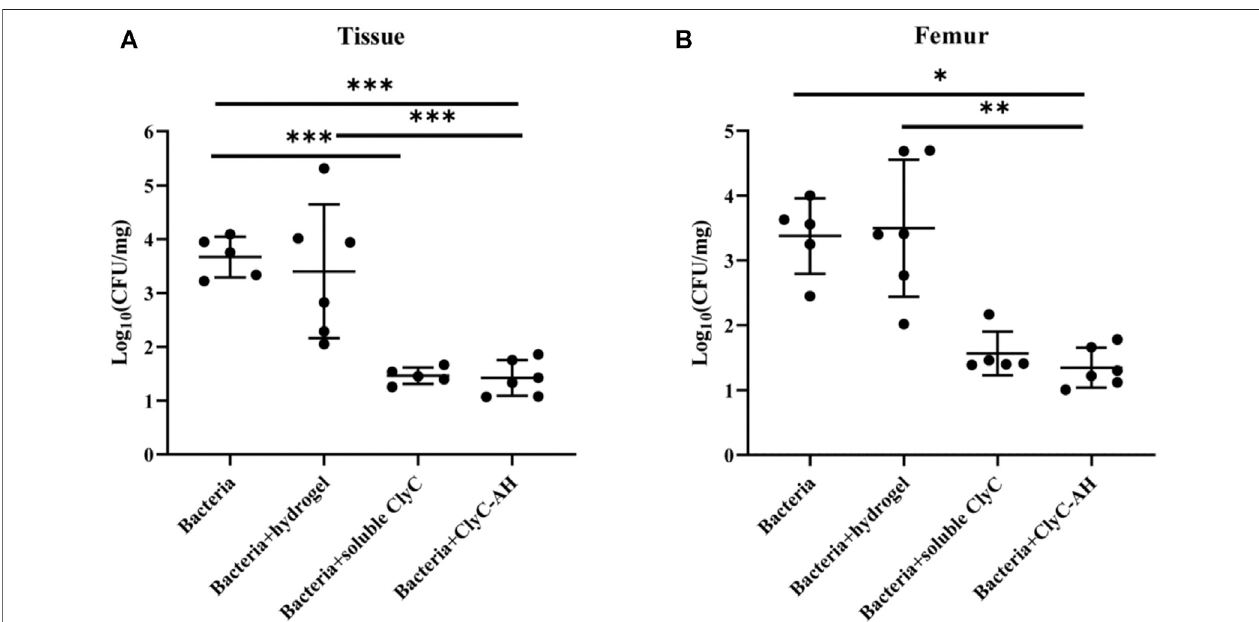
FIGURE6| ClyC-AHreducedbacteriaintheinfected femur. After7 days, S.aureus T23recoveryfrom (A) femurbone (B) tissue surroundingthefemur. Errorbars representstandarddeviations.* p < 0.05,** p < 0.01,*** p < 0.001.Kruskal – WallistestwithDunn ’ smultiplecomparisonstestforA.ANOVAwithTukey ’ s posthoc testfor B. Mean ± SD, n (cid:2) 5 – 6 per